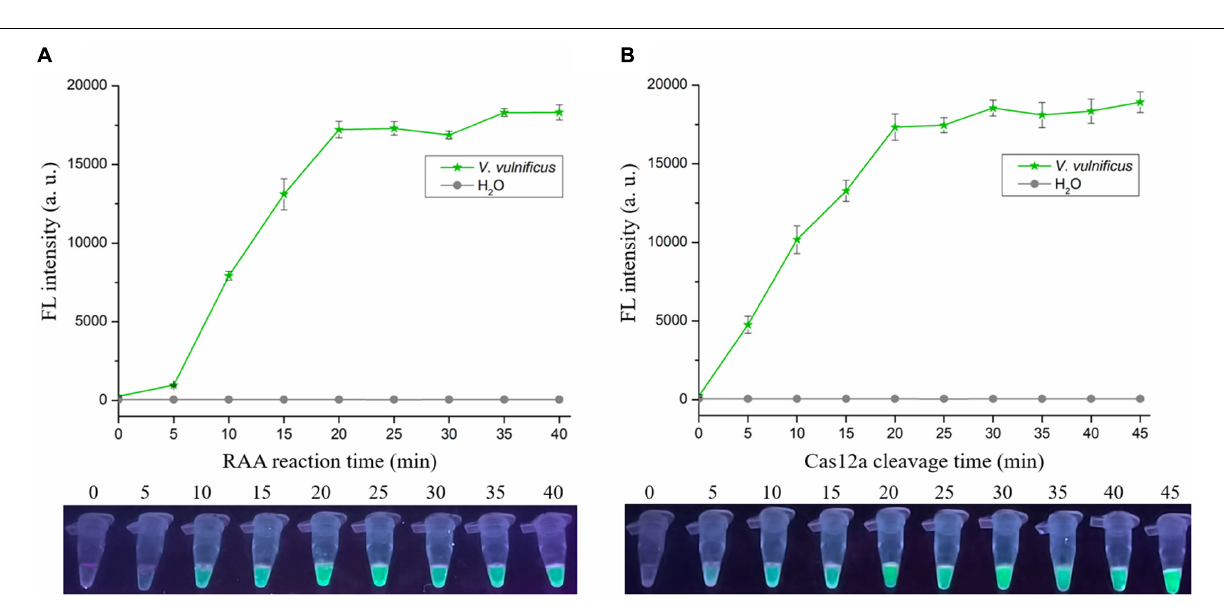
FIGURE 3 | Optimizing the RAA reaction time and Cas12a cleavage time. The RAA-CRISPR/Cas12a assay was performed using 1 × 10 4 copies/ µ L of V. vulnificus genomic DNA as the template, F7/R7 as the primer set, and CR3 + 4 as the crRNA to optimize the RAA reaction time (A) and Cas12a cleavage time (B) , and the fluorescence signal was analyzed using a multifunctional microplate reader (upper) or a UV torch